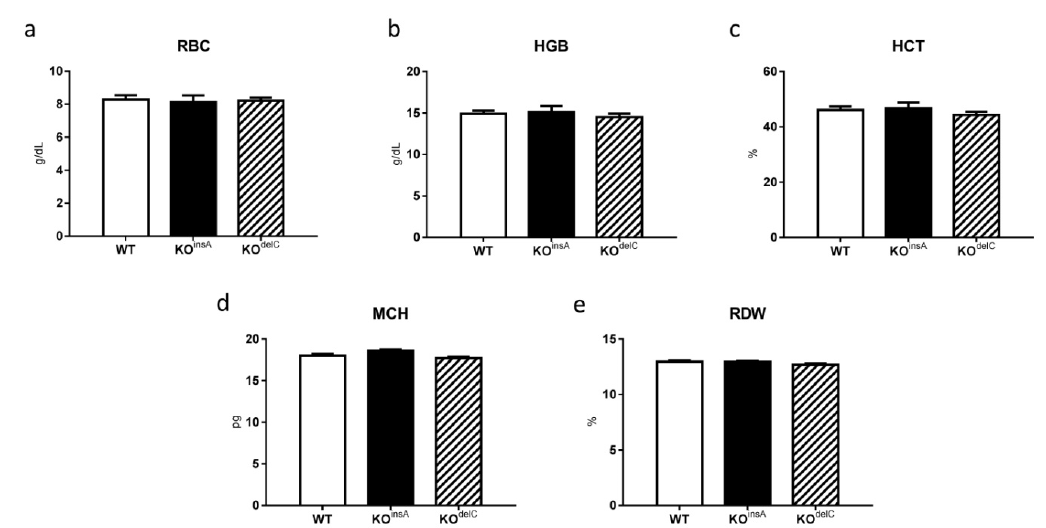
Figure 4. Hematology parameters of WT and TAAR9-KO rats. Minimal changes between genotypes were detected in ( a ) red blood cells (RBC), ( b ) hemoglobin (HGB), ( c ) hematocrit (HCT), ( d ) mean corpuscular hemoglobin (MCH), ( e ) red blood cell distribution width (RDW). Data are mean ± SEM, n = 7 per group.